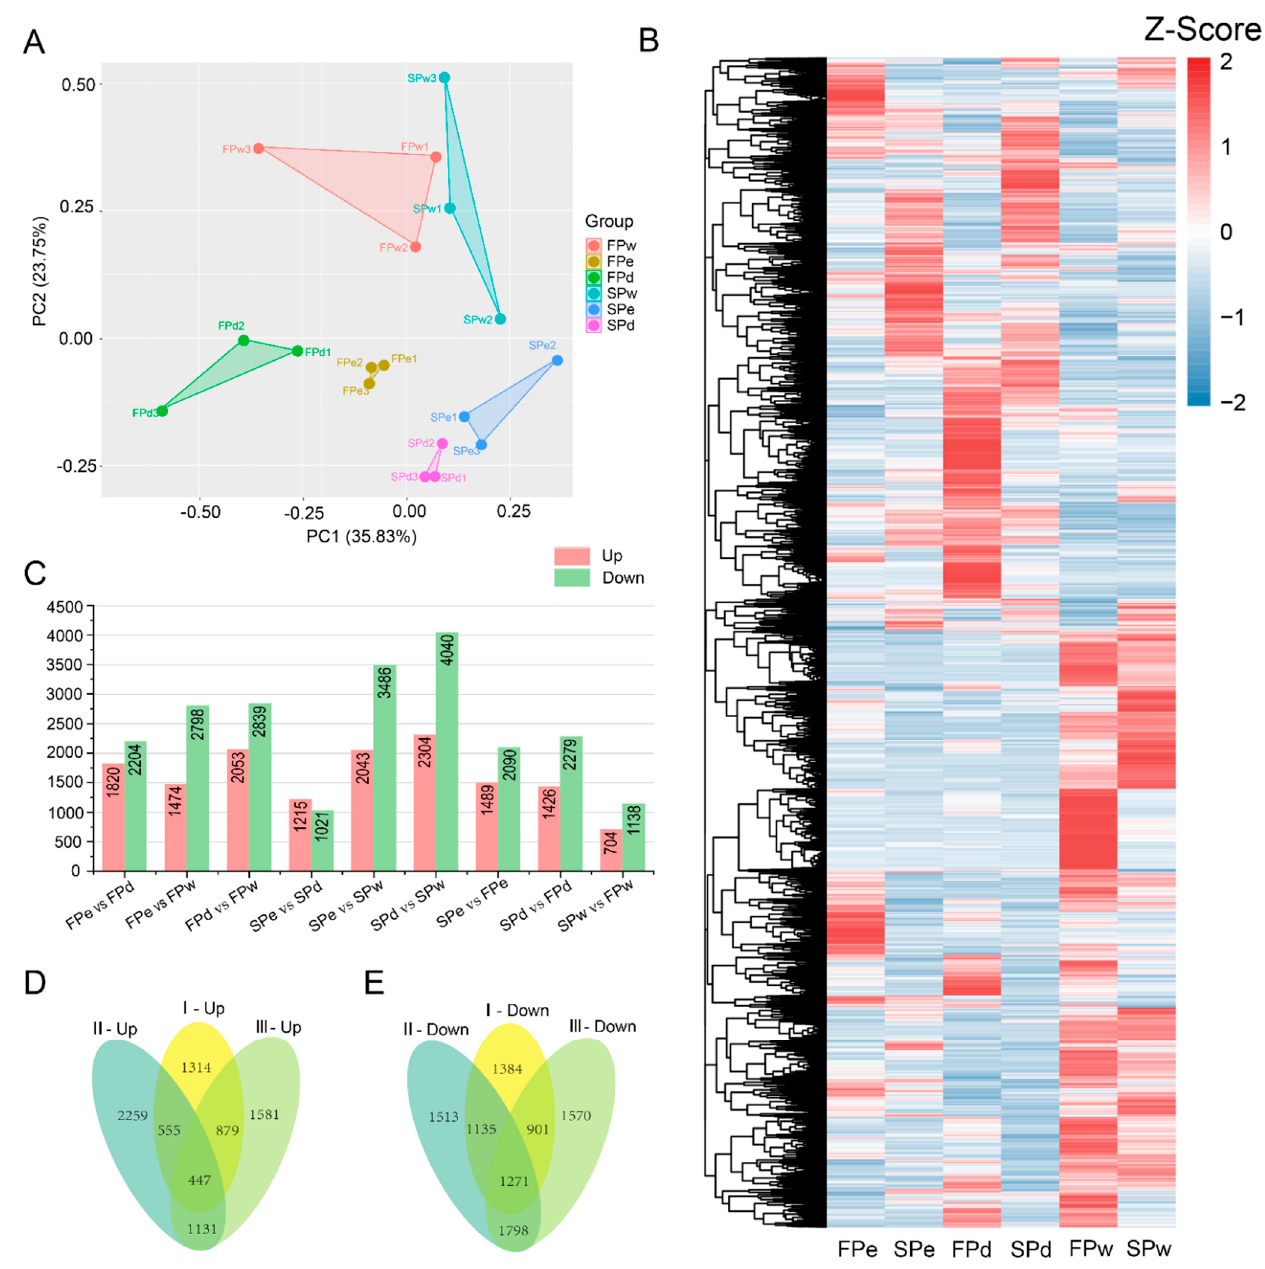
Figure 2. Differentially expressed genes (DEGs) in xylem of three poplar hybrids under full sun and shade conditions: ( A ) Principal component analysis (PCA) of the expressed genes showed the uniformity between biological replicates; ( B ) Hierarchical cluster analysis of total DEGs—rows and columns in the heatmaps represent genes and samples, respectively; ( C ) The number of up- and down-regulated genes in pairwise comparisons between three hybrids under different conditions and the same conditions; ( D ) and ( E ) Venn diagrams of up- and down-regulated genes within and between poplar